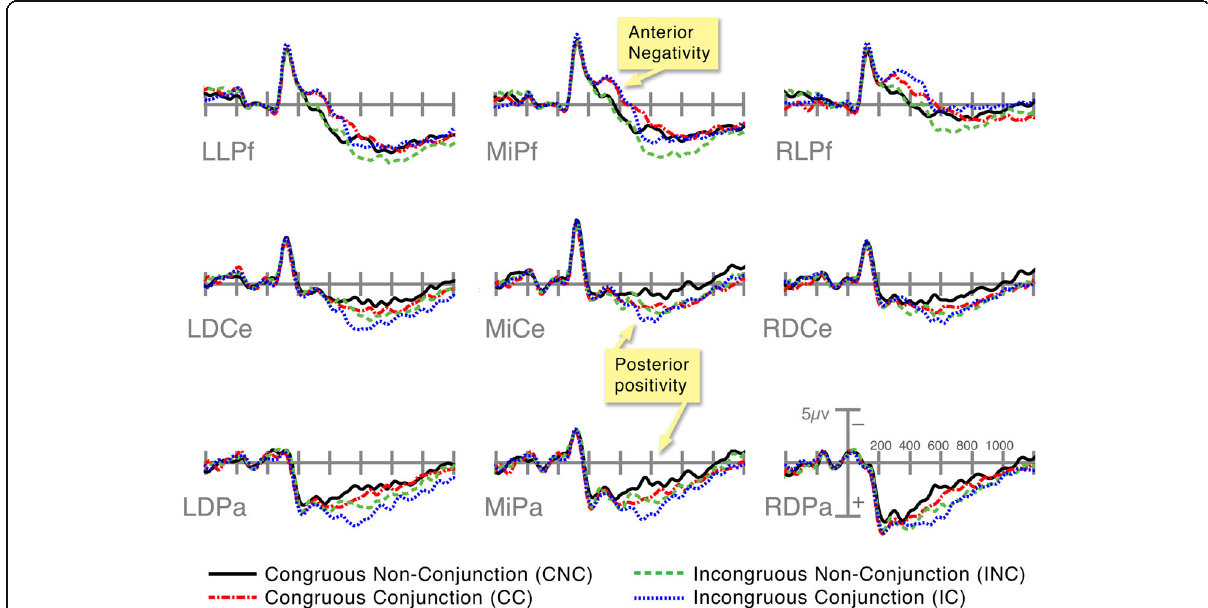
Fig. 5 Illustration of grand-averaged ERPs time-locked to the critical panel across all sequence types at Prefrontal, Central, and Parietal electrode sites. L left, L lateral, Pa parietal, Pf prefrontal, R right, Mi Midline, Ce